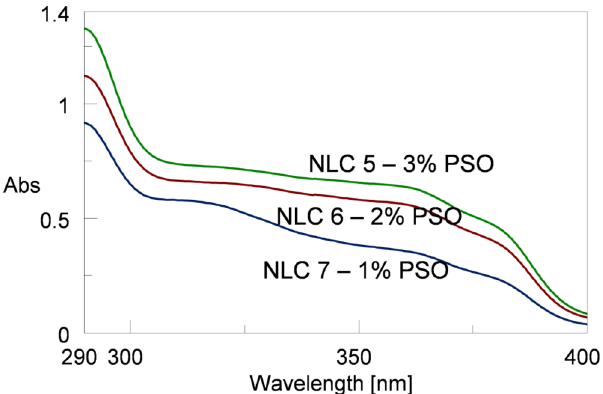
Figure 9. UV absorbance of OCT_AVO – NLCs based on Em:Wax:PSO in dispersion synthesised with diferent concentrations of pomegranate seed oil.